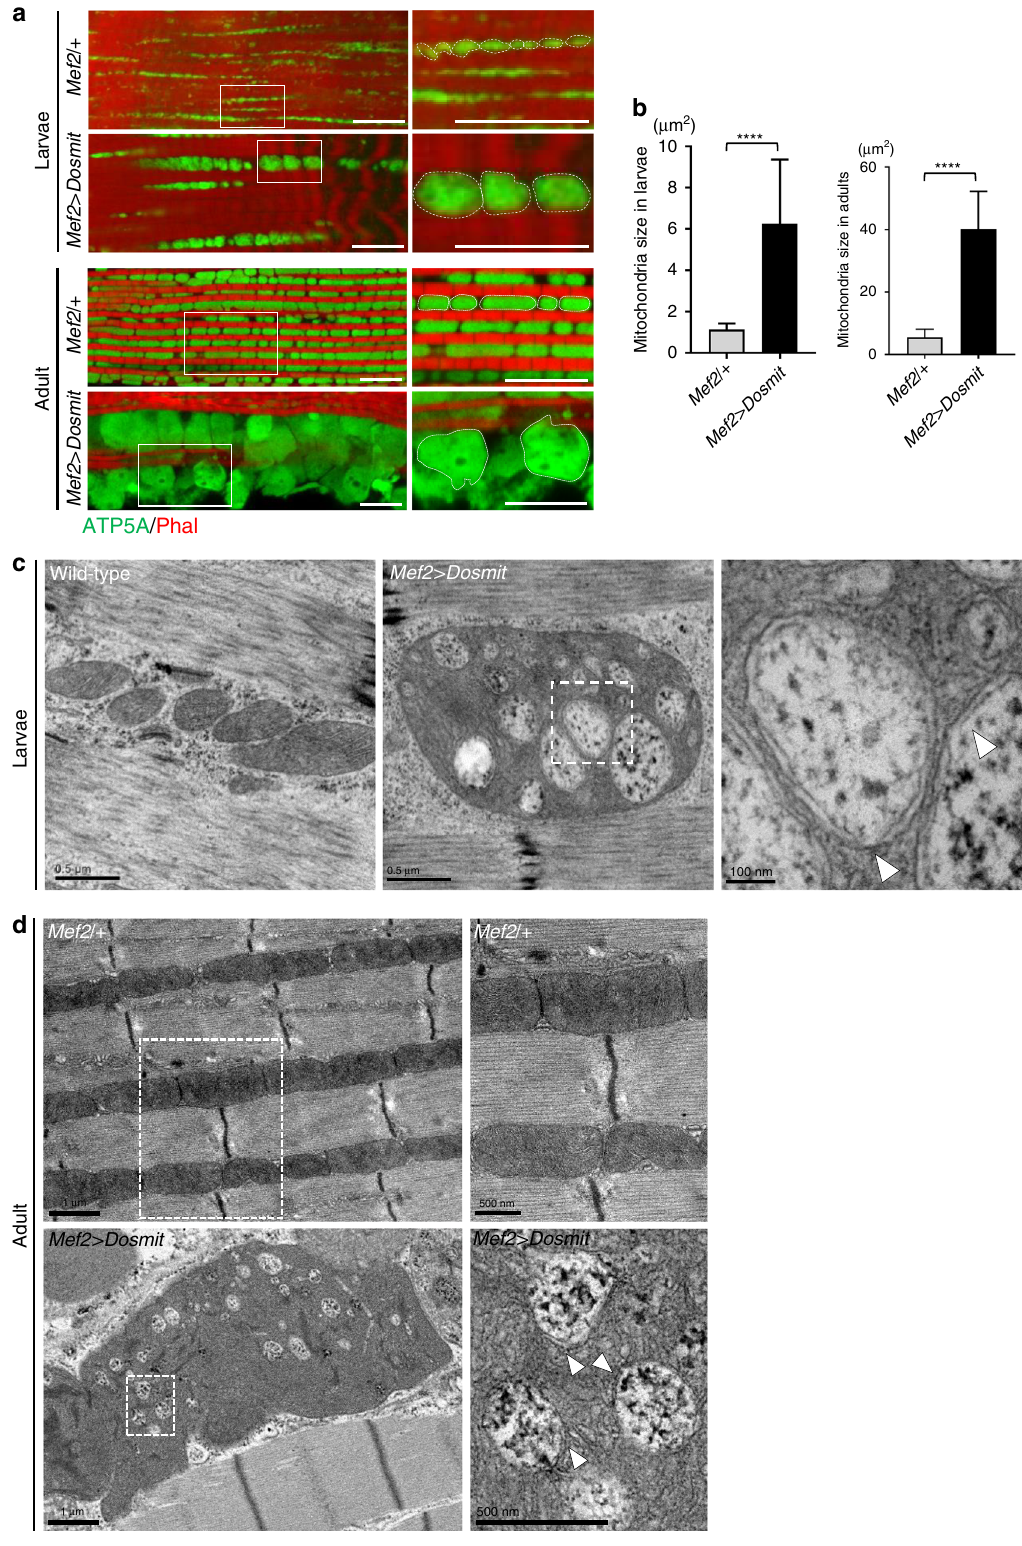
To further con fi rm whether the signal from the puncta in the intramitochondrial vesicles was generated by GFP, we conducted immunogold labeling of GFP (Fig. 5e). Signi fi cantly more gold particles were localized in the intramitochondrial vesicles of the enlarged mitochondria than in the mitochondria in control muscle (Fig. 5e, f). Dosmit-induced intramitochondrial vesicle